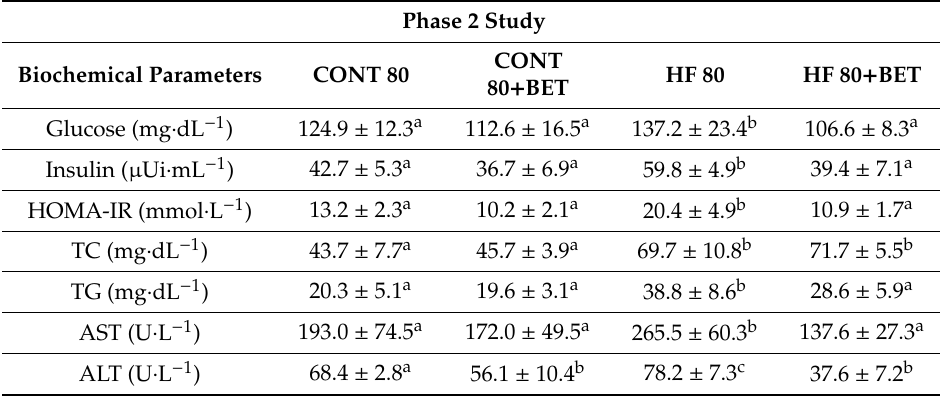
Table 3. Plasma biochemical parameters after phase 2 of feed